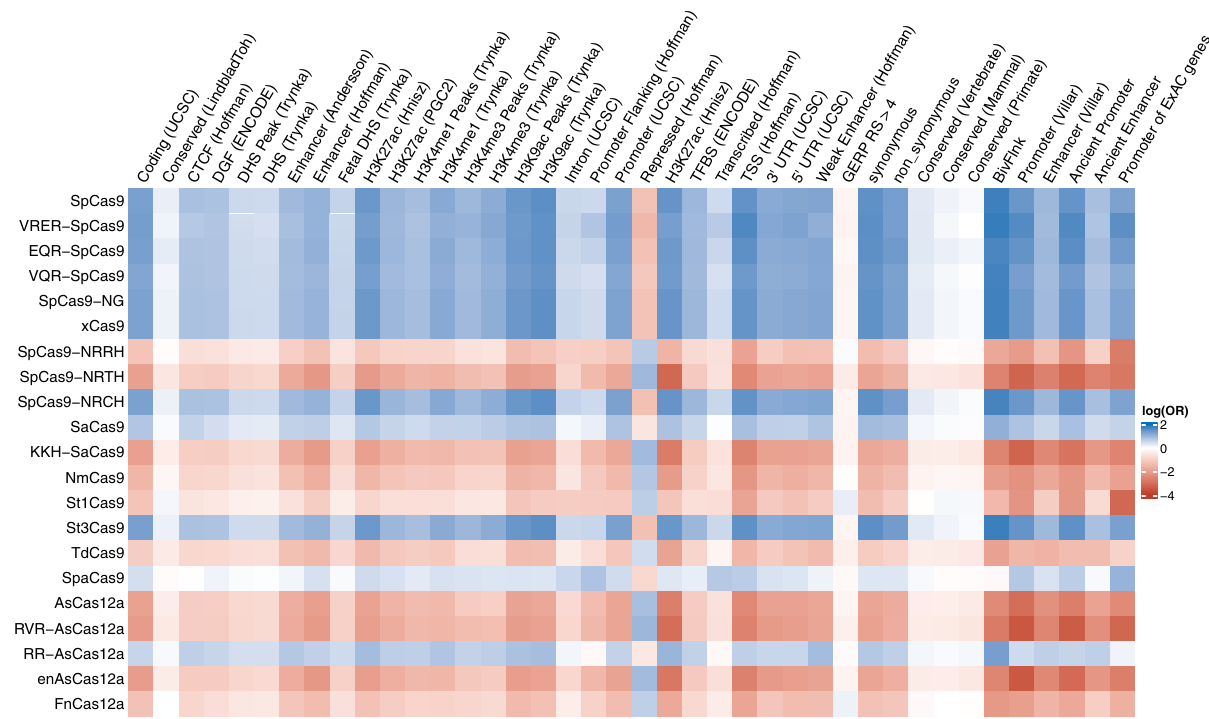
Fig. 3 Cas using GC-rich PAMs shows more overlap with functional annotations. The rows represent Cas annotations, while the columns represent functional annotations (see Supplementary Data 4 for details). The odds ratio (OR) between pairs of Cas annotation and functional annotation was calculated by Fisher ’ s Exact test on n = 9,997,231 SNPs. The plot shows log(OR), in which blue indicates OR